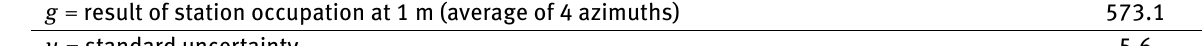
Table 5: Calculation of the station occupation value g at 1 m height for GABL-M at the station TsNIIGAiK 110 from the results at the effective height in four different azimuths. Only the last digits of the gravity values are shown. Some of the columns are self-explanatory. The trans- fer correction (column 7) from the effective height (column 2) to 1 m height and the standard uncertainty u are derived from the second degree polynomial depicted in Fig. 2. Column 9 is then the sum of columns 3 and 7. The g is calculated as an average of the four g values in column 9. The standard uncertainty u of g is calculated as u = [4.5 + ( s 2 i